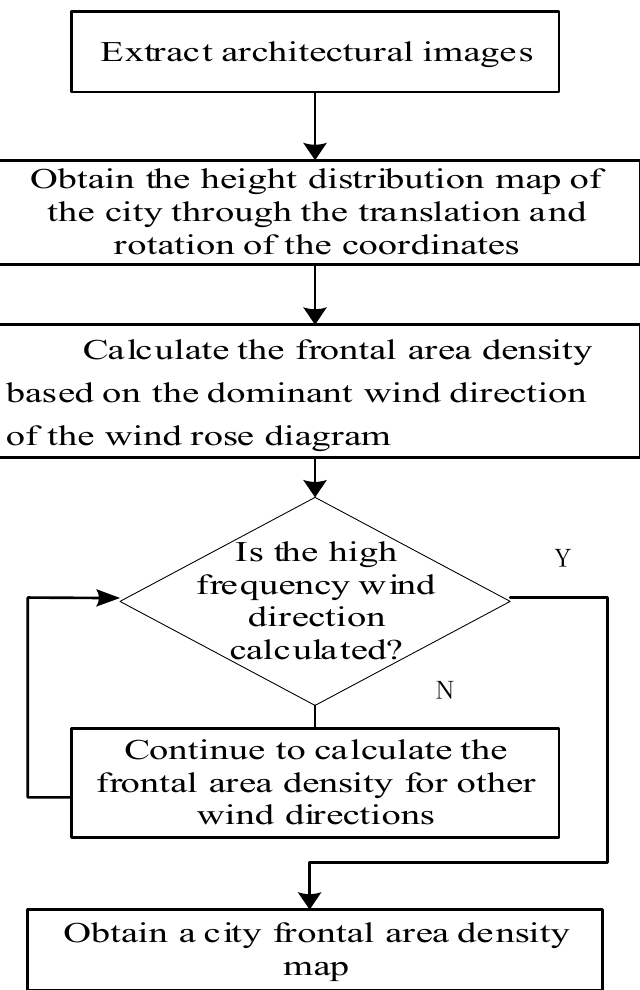
Figure 7. The calculation process of the frontal area density of urban buildings. The calculated frontal area density in summer and winter are shown in Figure 8a,b, respectively.